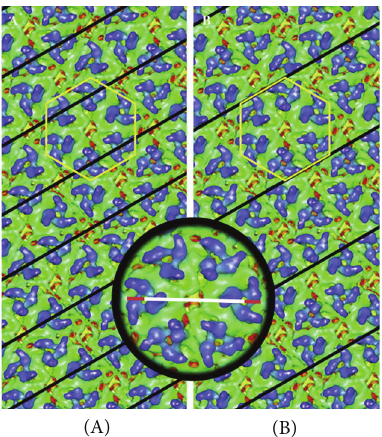
Figure 9: Helical reconstruction of the tubular section of the furin sensitive E1-392/E2-341 created by 6-fold rotational arrays (highlighted). Black lines illustrate the 16nm repeat (A) and the 20 nmrepeat(B)registersseenonthetubularsectionofthemutants. Illustrations are drawn to scale with the average width of the tubular structures. The insert illustrates the distances taken from a cryoelectron microscopy reconstruction of wild-type Sindbis virus measuring across a strict 2-fold axis of a hexagonal array: white is 16nm and white with red is 20 nm. Kononchik et al. 2009 [53].